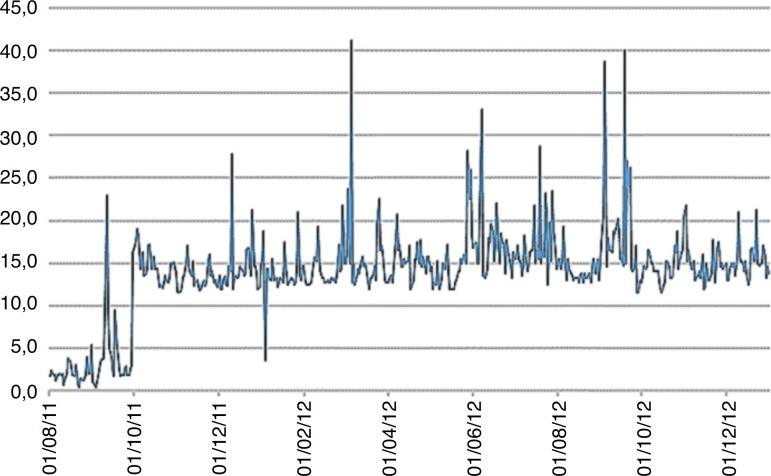
Valores diários, em µg/m3, das concentrações do poluente PM2.5. Taubaté, SP, 2011-2012.